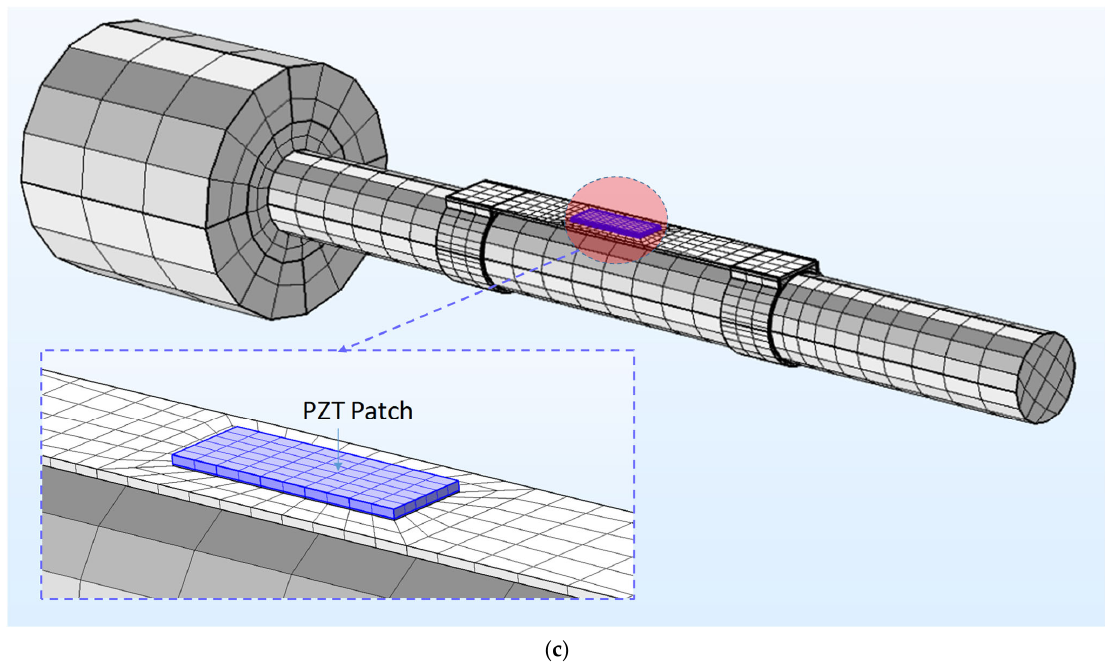
Figure 7. Finite element modeling of the smart strand. ( a ) Geometry of the finite element model: 3D view (unit: mm); ( b ) Geometry of the finite element model: top view (unit: mm); ( c ) Meshing of the finite element model.